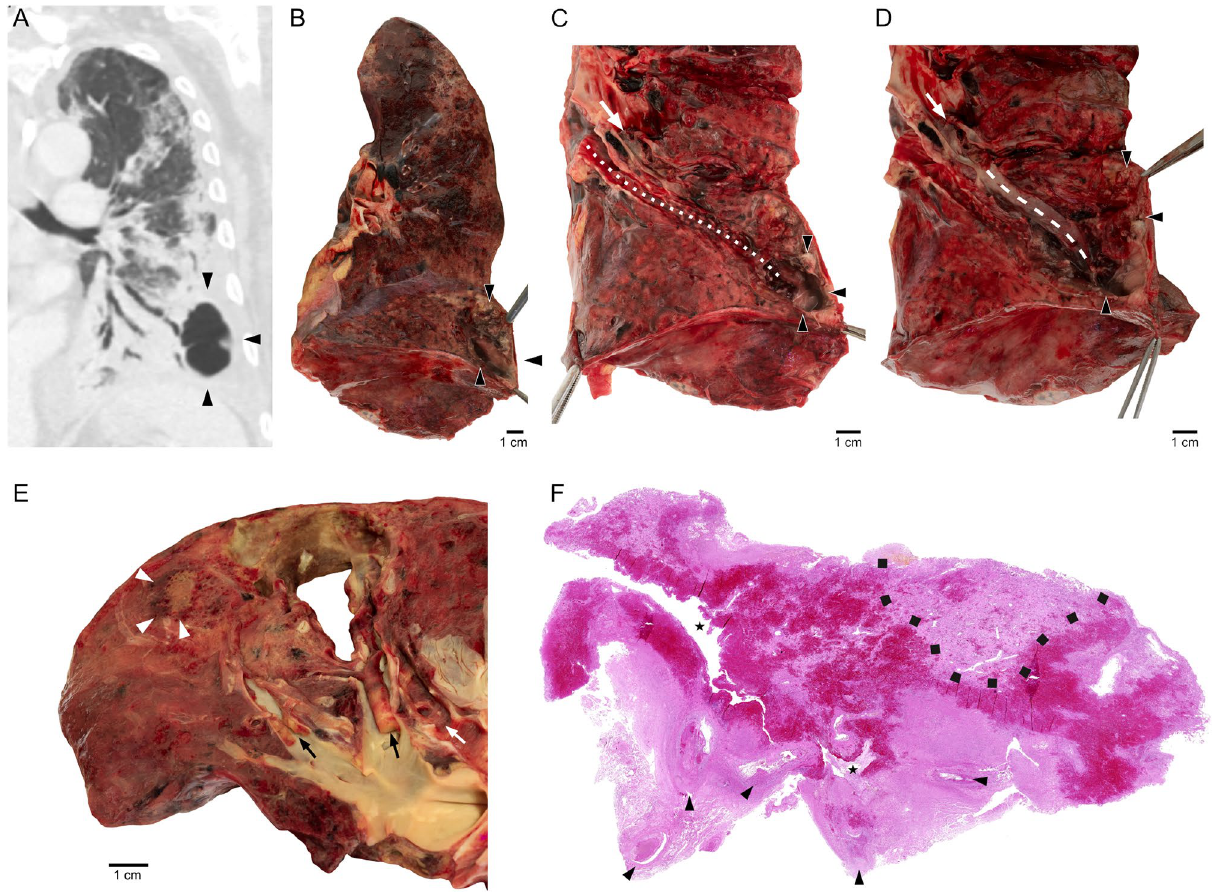
Figure 2. Postmortem findings in two patients. ( A )–( D ) show findings in a 77-year old patient who died 42 days after ICU admission. ( A ) Frontal reconstruction of lung CT showing large basal, left-sided cavity (corresponding to cross-sectional CT scan in Fig. 1B). Macroscopic findings during subsequent preparation steps show ( B ) opened lung cavity with necrotic lining (arrowheads), ( C ) direct connection of an opened bronchus with the cavity (dotted line), corresponding to positive aerogram on CT ( A ) and ( D ) a pulmonary artery branch (stippled line), directly connected with the necrotic cavity. A thrombotic vessel occlusion is indicated by white arrows. ( E ) and ( F ) show macro- and microscopic findings in a 69-year old patient, who died 33 days after ICU admission. ( E ) Opened pulmonary artery branches with subtotal (left) and total (right) occlusion of the vessel lumen (black arrows), and a directly adjacent lung cavity, suggesting that the large thrombus on the right has caused liquefactive infarct necrosis of the lung parenchyma. The necrotic area has gained access to the bronchial system (white arrow). The adjacent lung parenchyma shows a combined anemic and hemorrhagic infarct (arrowheads) that has not undergone cavitary transformation. ( F ) Histological sectioning (HE) shows multiple thrombotic occlusions (arrowheads) of pulmonary artery branches with consecutive anemic infarct necrosis (light red zones) with entrapment of bronchial airways (asterisks). Dark red zones around the bronchial airways represent hemorrhagic necrosis. The black dotted line delineates a small area of vital lung